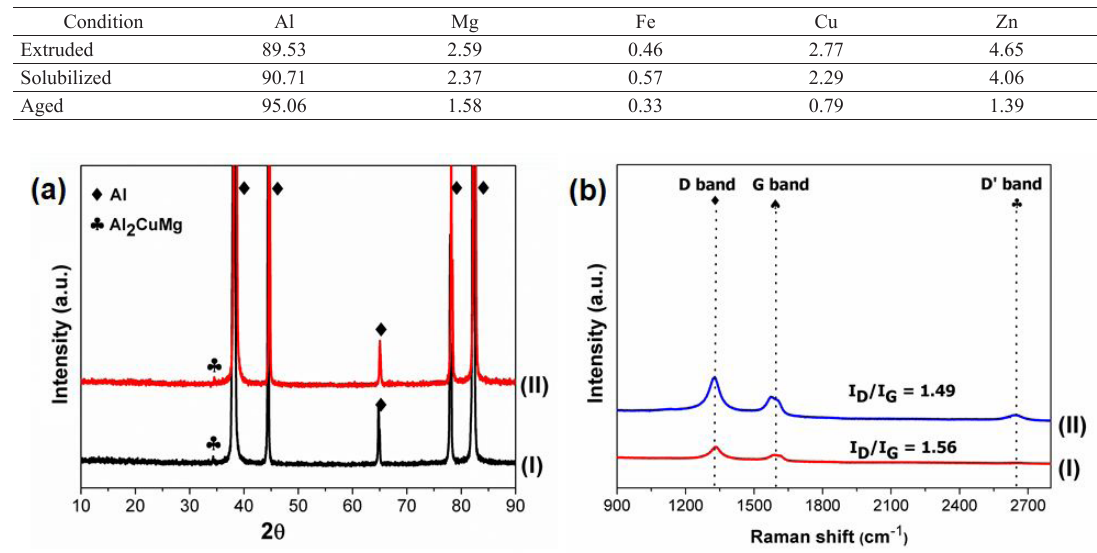
Figure 6. Composite B (a) XRD patterns of the composite (I) as extruded composite without heat treatment, (II) artificial aged composite; and (b) Raman spectra of (I) as hot extruded, (II) after solubilized treatment.